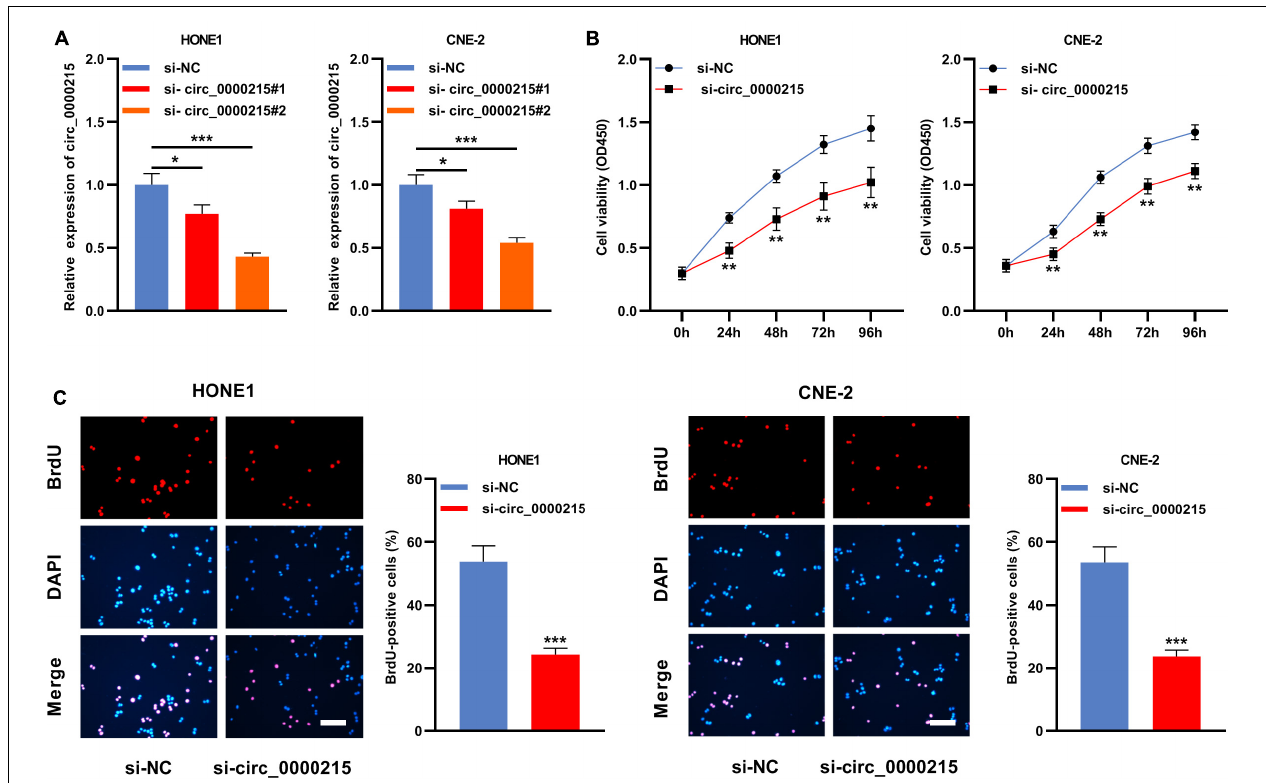
FIGURE 3 | Knockdown of circ_0000215 impedes the multiplication of NPC cells. (A) Two siRNAs against circ_0000215 (si-circ_0000215#1 and si-circ_0000215#2) were transfected into HONE1 and CNE-2 cells, respectively. qRT-PCR confirmed that the expression of circ_0000215 was reduced after the transfection. (B) CCK-8 experiment was employed to detect the viability of HONE1 and CNE-2 cells transfected with si-circ_0000215. (C) BrdU experiment was implemented to examine the proliferation of HONE1 and CNE-2 cells transfected with si-circ_0000215. Scale bar, 50 µ M. The significance of difference was determined by Student’s t -test or one-way ANOVA. * P < 0.05, ** P < 0.01, and *** P < 0.001. Data from three independent experiments were expressed as mean ± standard deviation.